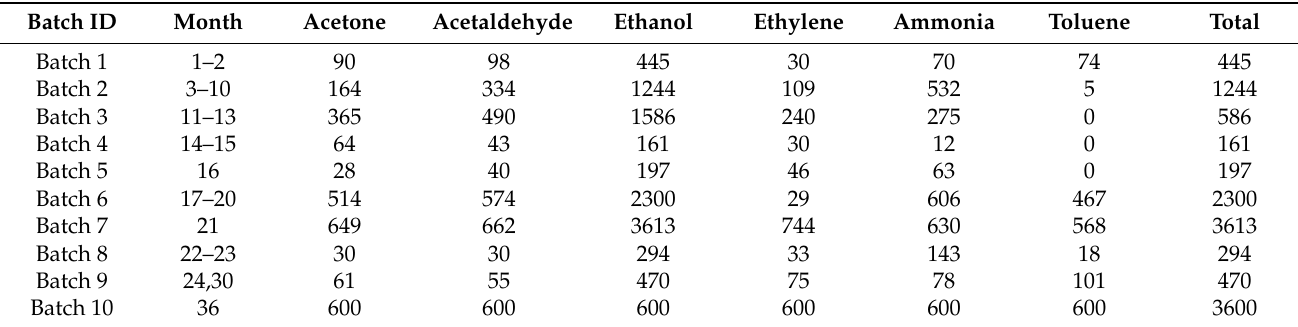
Table 1. Brief of drift dataset.